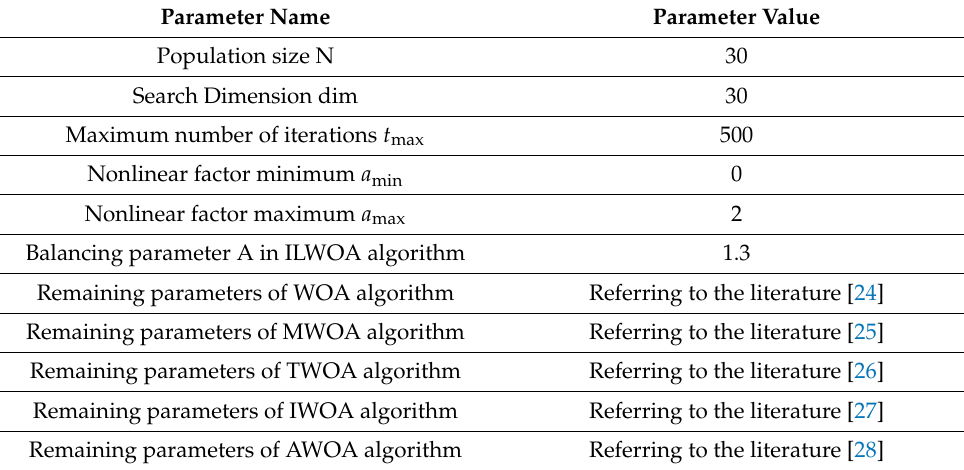
Table 1. Algorithm parameter settings.